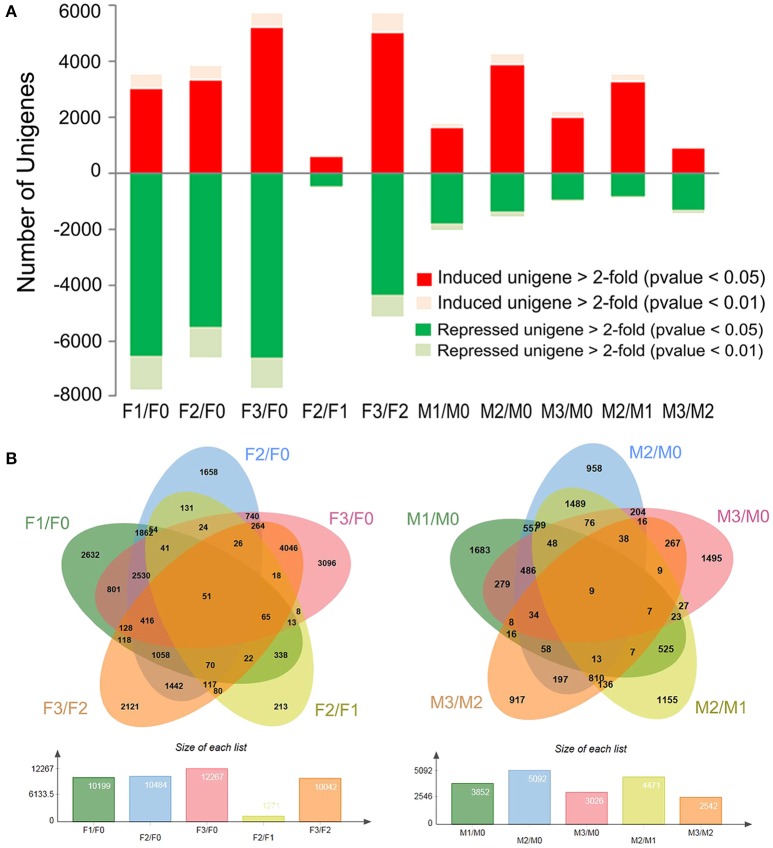
Global changes in gene expression in resistant V. montana and susceptible V. fordii during F. oxysporum infection. (A) The number of >2-fold induced and repressed unigenes (p < 0.05 and 0.01) for F1 vs. F0, F2 vs. F1 and F3 vs. F2 and for M1 vs. M0, M2 vs. M1 and M3 vs. M2; (B) the numbers of commonly and specifically induced and repressed unigenes at different stages of F. oxysporum infection in the two species are shown in the overlapping and non-overlapping regions, respectively.